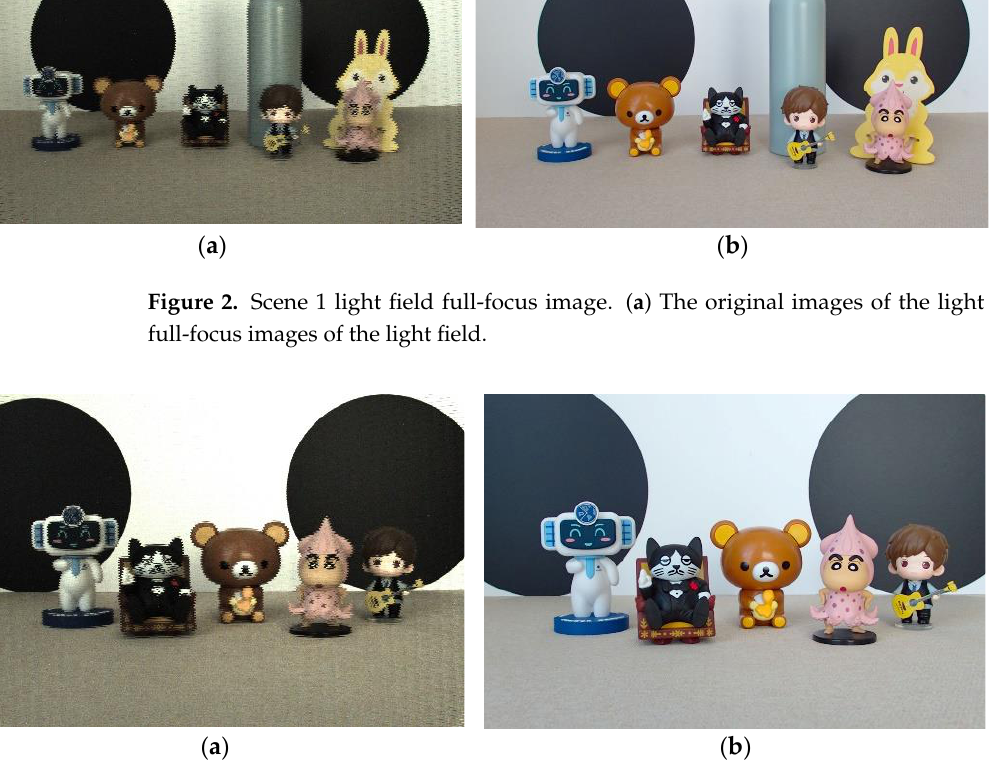
Figure 3. Scene 2 light field full-focus image. ( a ) The original images of the light field. ( b ) The full-focus images of the light field.